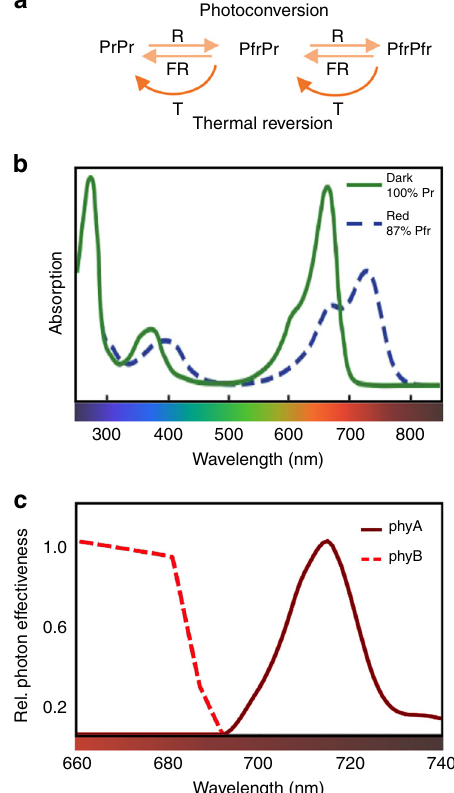
Fig. 1 Control of phytochrome activity. a Factors controlling phytochrome activity. Phytochromes exist in two conformations, Pr and Pfr, the latter being the active form. They exist as dimers so three species can be found. Each monomer can be activated by red light (R) and inactivated by far-red light (FR) or by thermal reversion, a process that depends on temperature ( T ). At least in the case of phyB, Pfr in heterodimers reverts much faster than that in homodimers, allowing phyB to perceive temperature both during the day and during the night. b Plant phytochrome absorption spectra of the Pr and Pfr conformations. In dark-adapted seedlings phytochromes are in the Pr form. Upon a saturating R pulse, due to overlapping absorption spectra of Pr and Pfr, only 87% of Pfr is achieved. c Action spectra for phyA and phyB in the control of hypocotyl elongation. Data from Klose et al. 3 . Fluence rate response curves are measured at different wavelengths and fl uence rate that leads to 40% inhibition compared with dark control is determined. In order to speci fi cally determine action spectra for phyA and phyB, for phyB the curve was performed with phyB-GFP/ phyAphyB seedlings, and for phyA using phyB-5 seedlings. Values are relative to the response obtained at the most ef fi